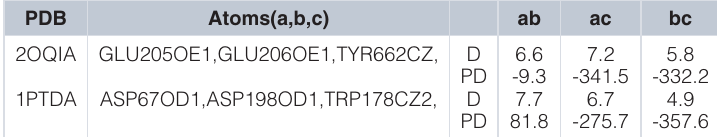
Table 4. Spatial and electrostatic congruence of a three residue partial motif. The match is significant and comprises active site residues (involved in the binding of myo-inositol in PDBid:1PTGA). Pair ‘ab’ is considered to be electrostatically congruent since the PD values are close to zero, and can be considered almost equipotential. This is expected for atoms of the same type from the same residue (GLU205OE1/GLU206OE1 and ASP67OD1/ASP198OD1). These three residues from PI-PLC (Asp67, Asp198 and Trp178) and corresponding three residues from DPP4 (Glu205, Glu206 and Tyr662) were used to superimpose DPP4 and PI-PLC. D = Pairwise distance in Å. PD = Pairwise potential difference. APBS writes out the electrostatic potential in dimensionless units of kT/e where k is Boltzmann’s constant, T is the temperature in K and e is the charge of an electron.